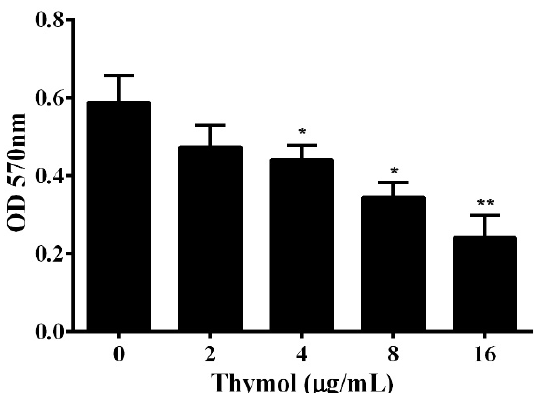
Figure 4. Influence of thymol on A. hydrophila biofilm formation. Biofilm formation assay was performed in a 96-well plate and the amount of biofilm was determined 24 h after thymol was added into the plate. The results are presented as the mean value ± SD ( n = 3) (*, p < 0.05; **, p < 0.01).